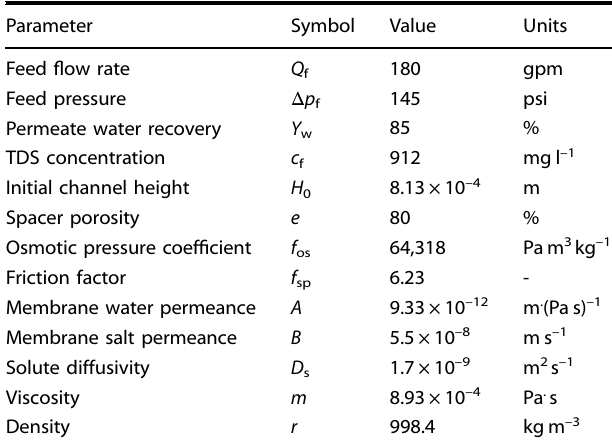
Table 2. Values of parameters used in the model.